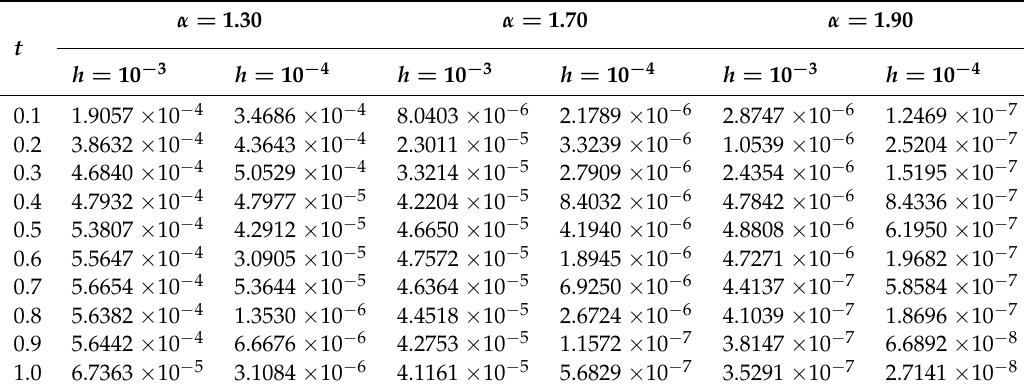
Table 2. Absolute error at each point, t when solving Example 1 using FEAM3 for different step size, h and 1 < α < 2.